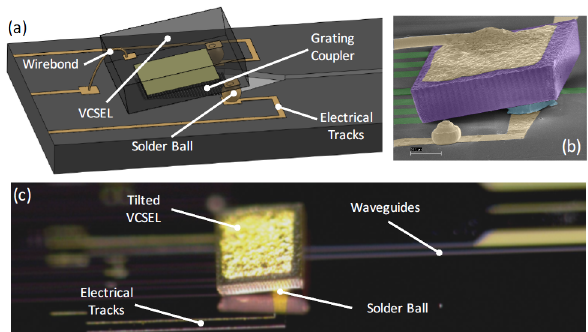
Figure 10. Tilted vertical cavity surface emitting laser (VCSEL) to Si ‐ PIC integration; ( a ) Schematic of the tilted ‐ VCSEL geometry, showing the VCSEL positioned above the grating ‐ coupler on the Si ‐ PIC, and the tilt being provided by the solder balls; ( b ) SEM (scanning electron micrsoscope) image of a tilted VCSEL on the Si ‐ PIC; ( c ) Microscope image of a tilted ‐ VCSEL on the Si ‐ PIC, showing the electrical ‐ tracks and on ‐ PIC waveguides used for routing the electrical and optical signals.